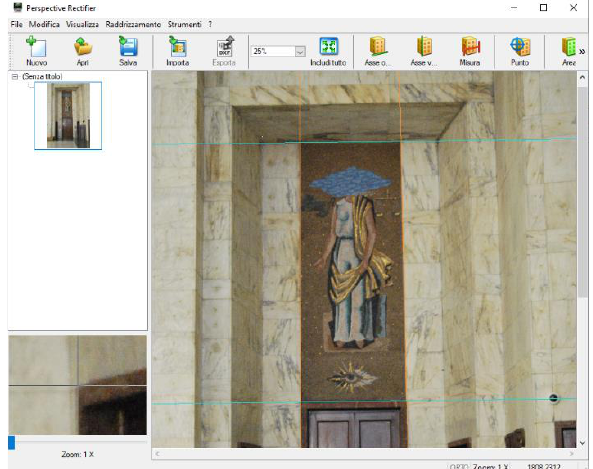
Fig 15. Gino Severini’s mosaic photo-rectification.